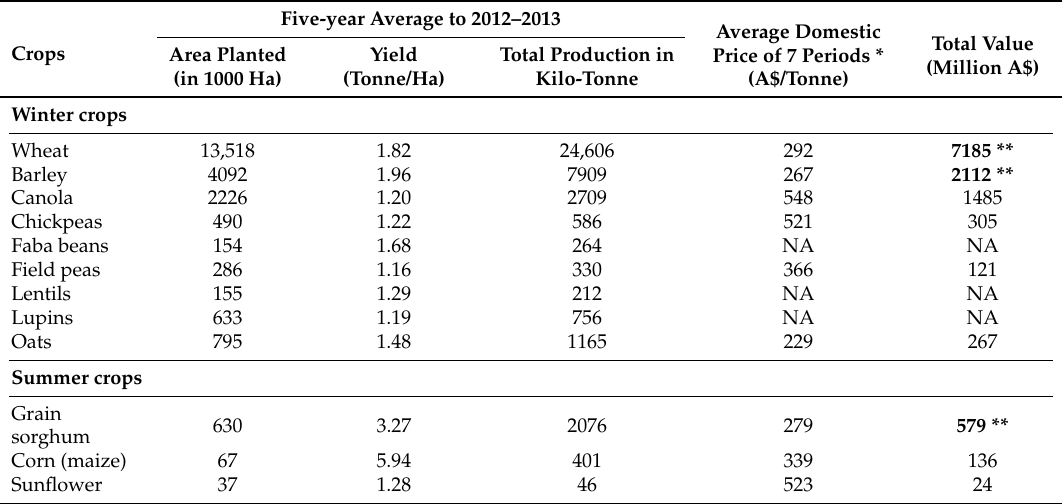
Table 1. Total value of different grain and oilseed crops.